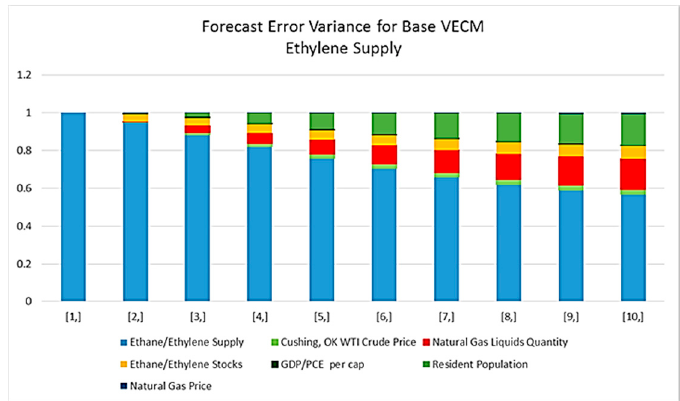
Figure 3. Forecast Error Variance Decomposition.